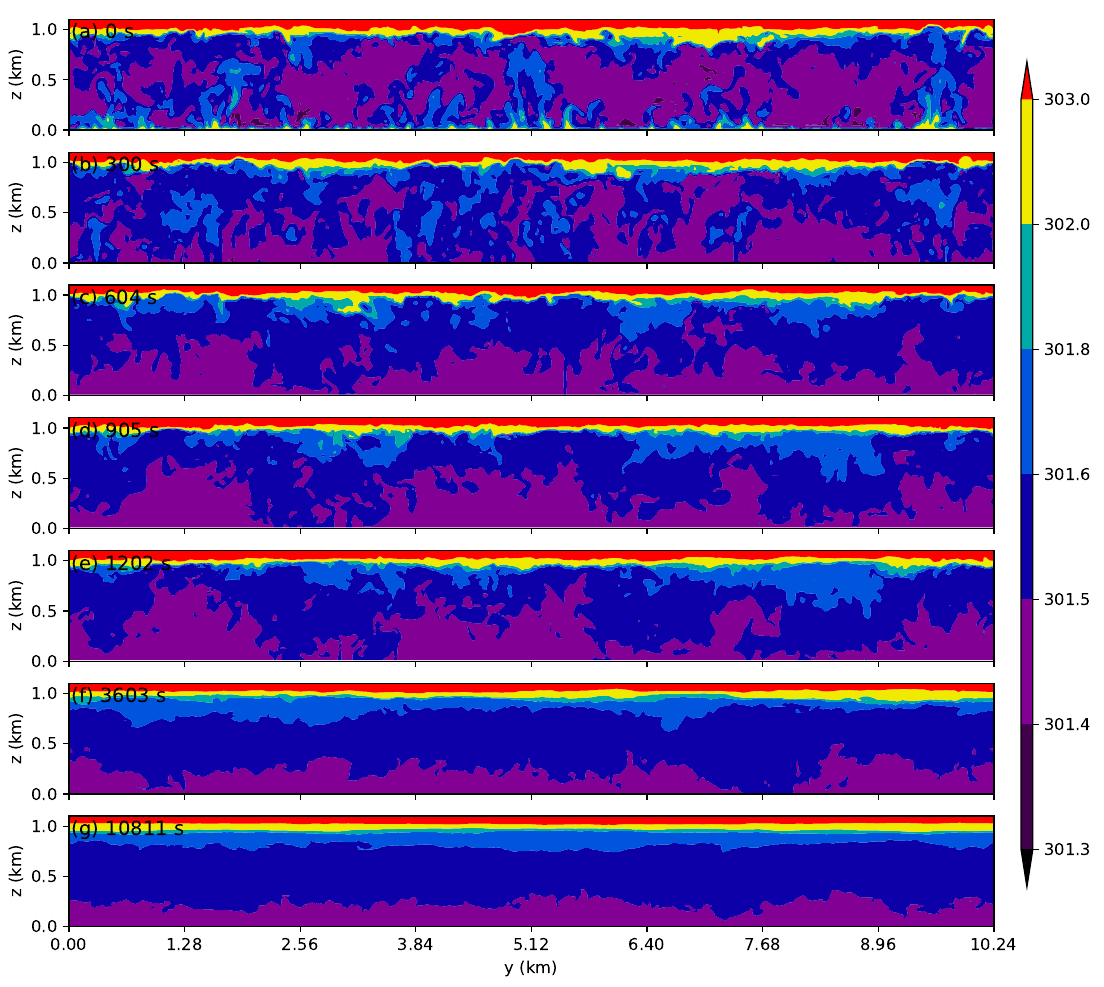
Figure 4. Potential temperature fields at x = 1270 m and t − t c = ( a ) 0, ( b ) 300, ( c ) 604, ( d ) 905, ( e ) 1202, ( f ) 3603, and ( g ) 10,811